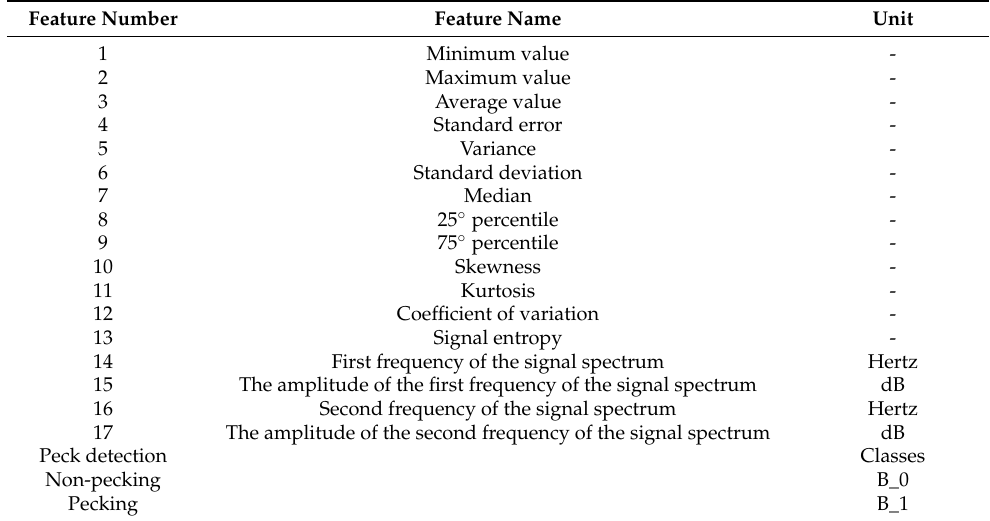
Table 1. Attributes included in the first dataset in the detection of pecking of broilers with two